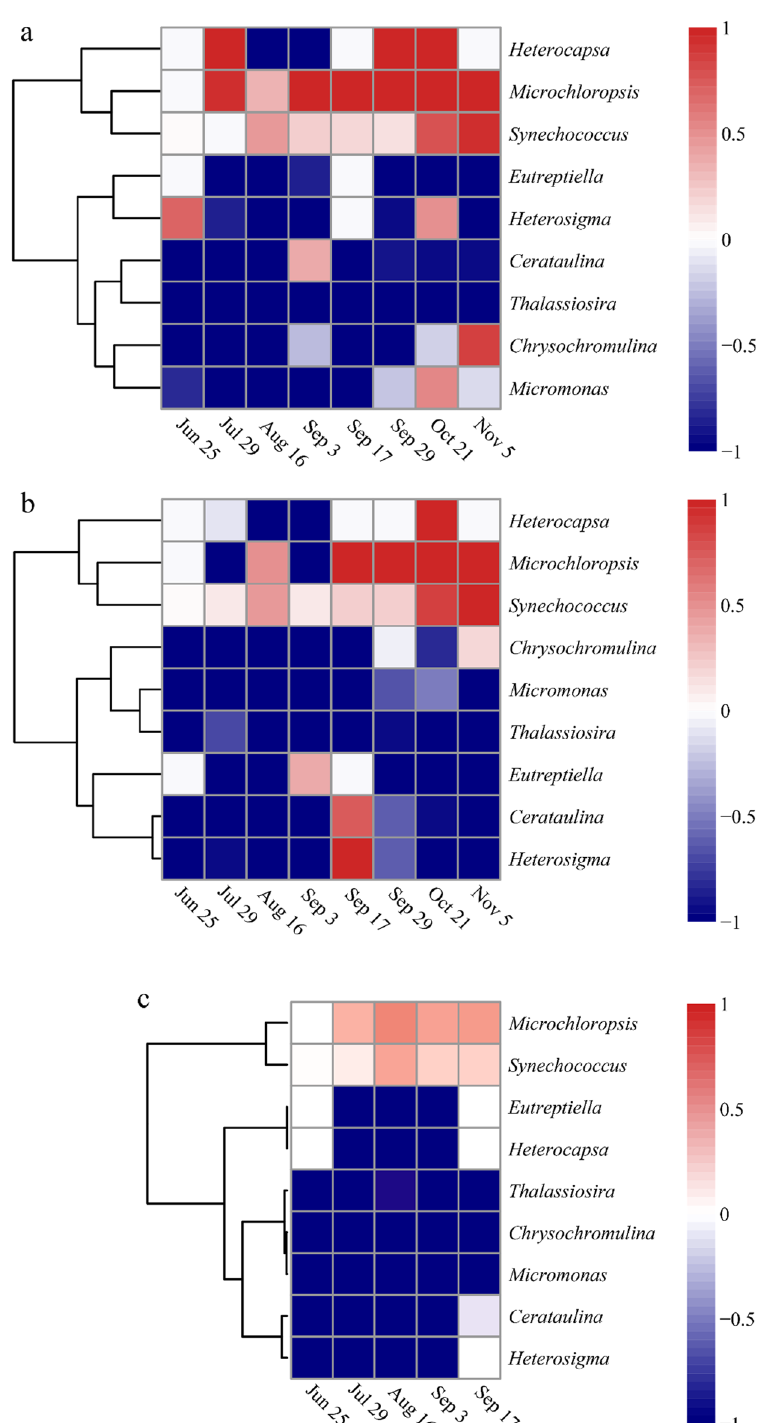
Figure 8. Heatmaps showing the feeding selectivity of M. mercenaria ( a ), M. meretrix ( b ), and R. philippinarum ( c ) on phytoplankton at the genus